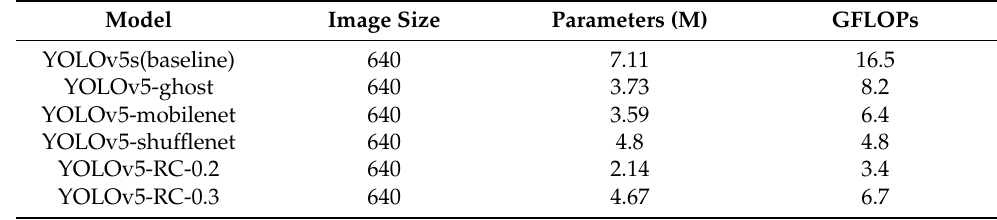
Table 4. Parameters and GFLOPs in YOLOv5 lightweight work under different